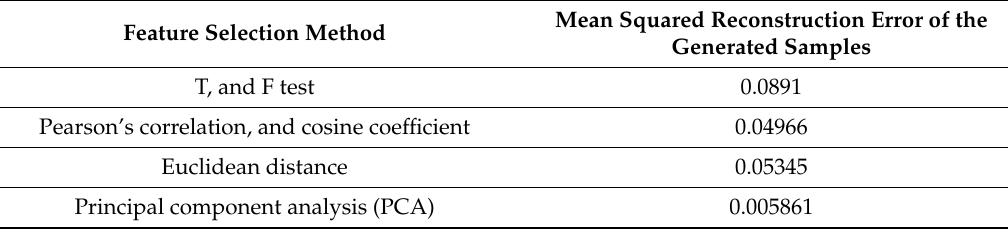
Table 5. The mean squared reconstruction error of the generated samples using sparse